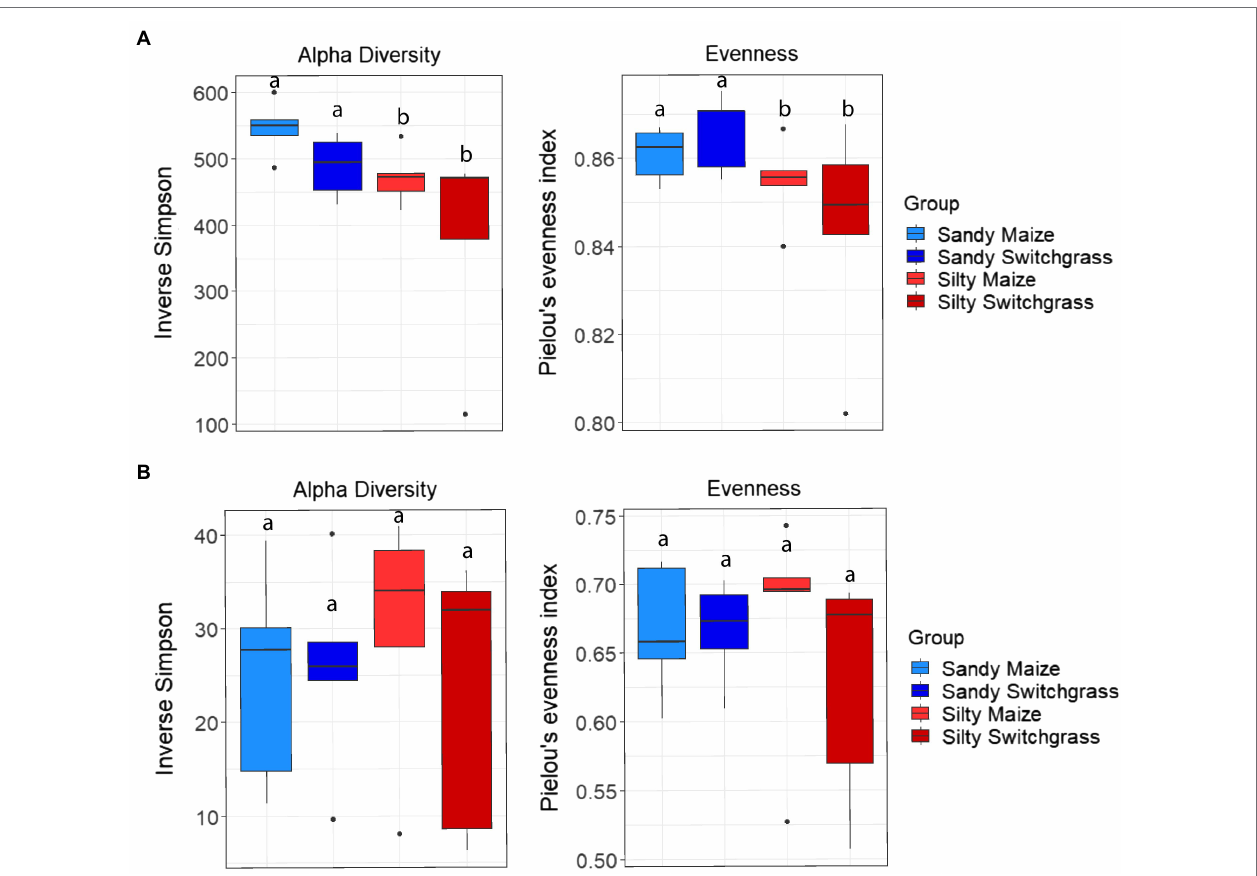
FIGURE 5 | Alpha diversity and evenness comparing site and crop influences on the RNA (A) and DNA (B) bacterial communities. Boxes encompass the 25th to 75th percentiles and whiskers extend to the maximum and minimum except when a point exceeds 150% of the interquartile range. Black bars indicate the mean and black dots denote outliers. Letters denote significance at p <